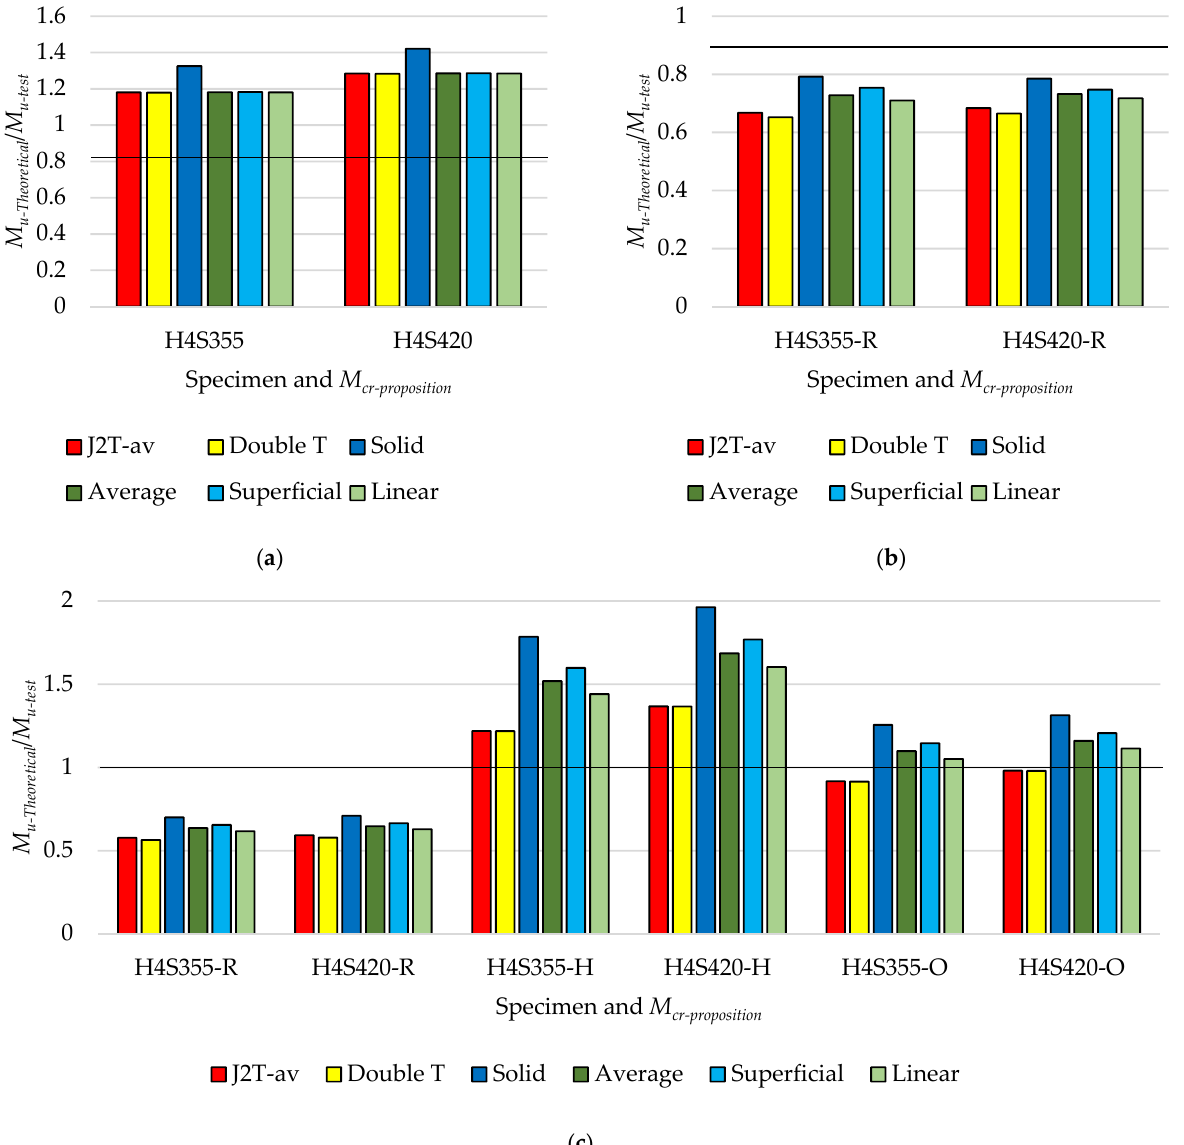
Figure 19. Accuracy obtained by the code’s adaptation approaches for composite castellated beams: ( a ) AS4100:1998 R2016 [105]; ( b ) ABNT NBR 8800: 2008 [108]; ( c ) EN 1994- 1-1: 2004 [107].